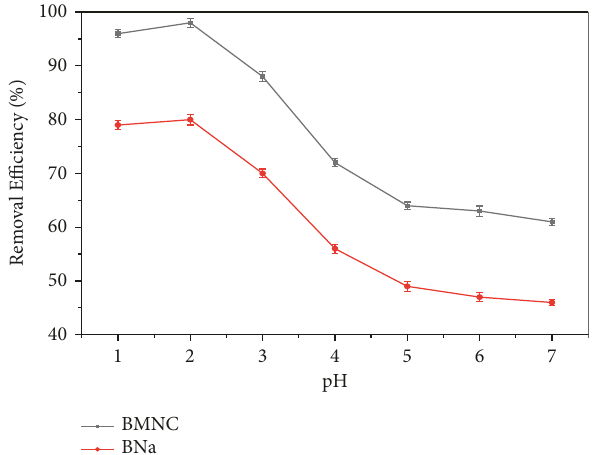
Figure 6: Effect of pH on adsorption of Cr(VI) ion by bentonite (BNa) and nanocomposite adsorbent (BMNC). Figure